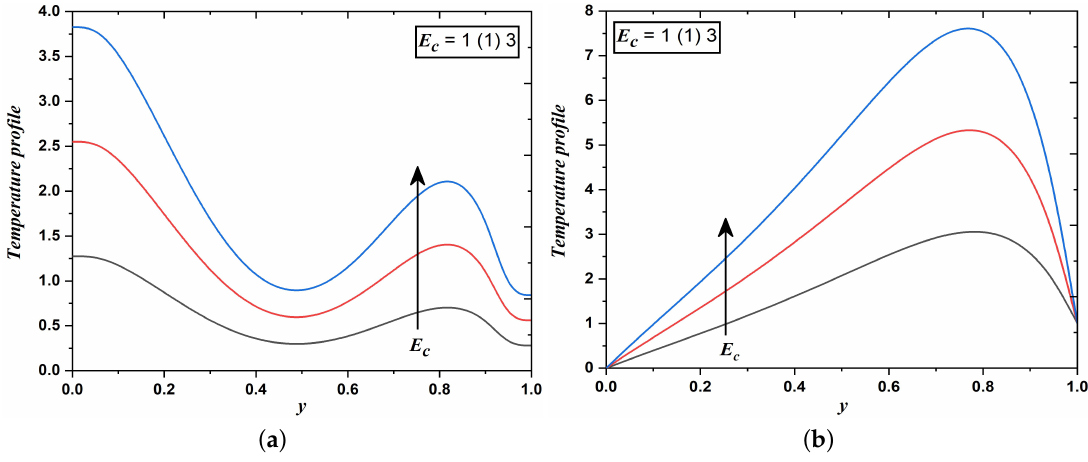
Figure 7. Temperature field when Eckert number varies (Case 1 & 2).